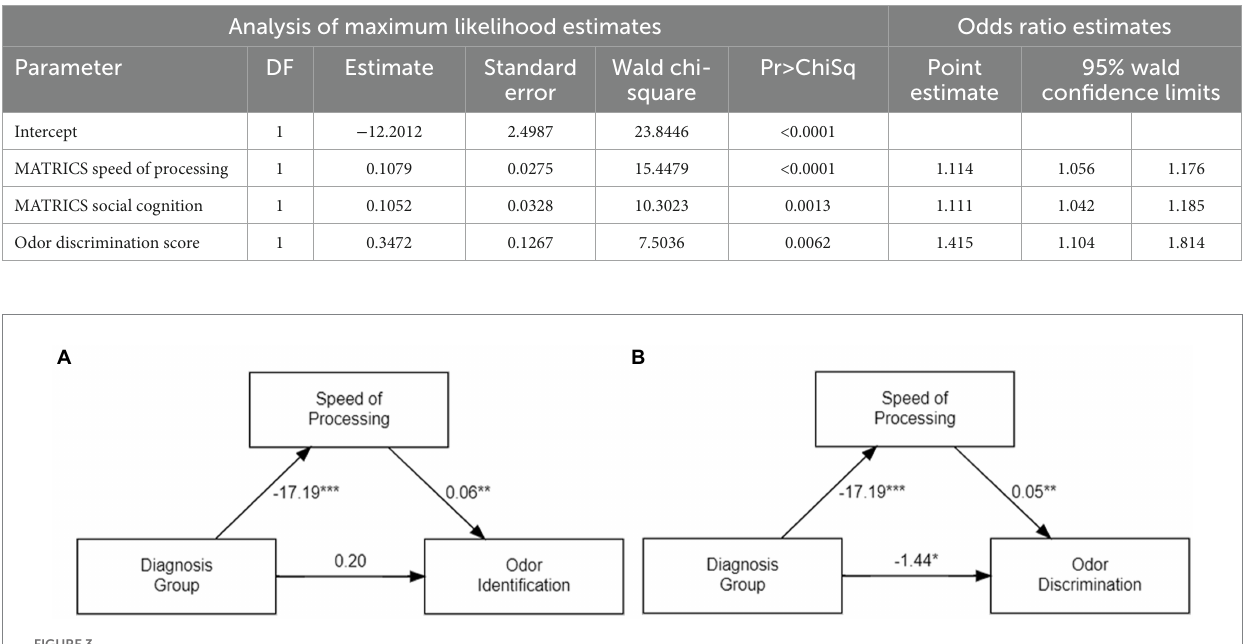
FIGURE 3 Graphical Representation of Mediation Effects of MATRICS Speed of Processing Score on Odor Identification (A) and Odor Discrimination (B) . Each number is the β value from the mediation analysis of either the direct effect (ADE) of diagnostic group (schizophrenia vs. control) on odor variables controlling for the mediator and covariates (age, sex and number of cigarettes smoked) ( bottom arrow ), or the indirect mediation effect (ACME) ( the product of the two side arrows ), Statistical significance of β value: * p < 0.05,** p < 0.01, *** p <